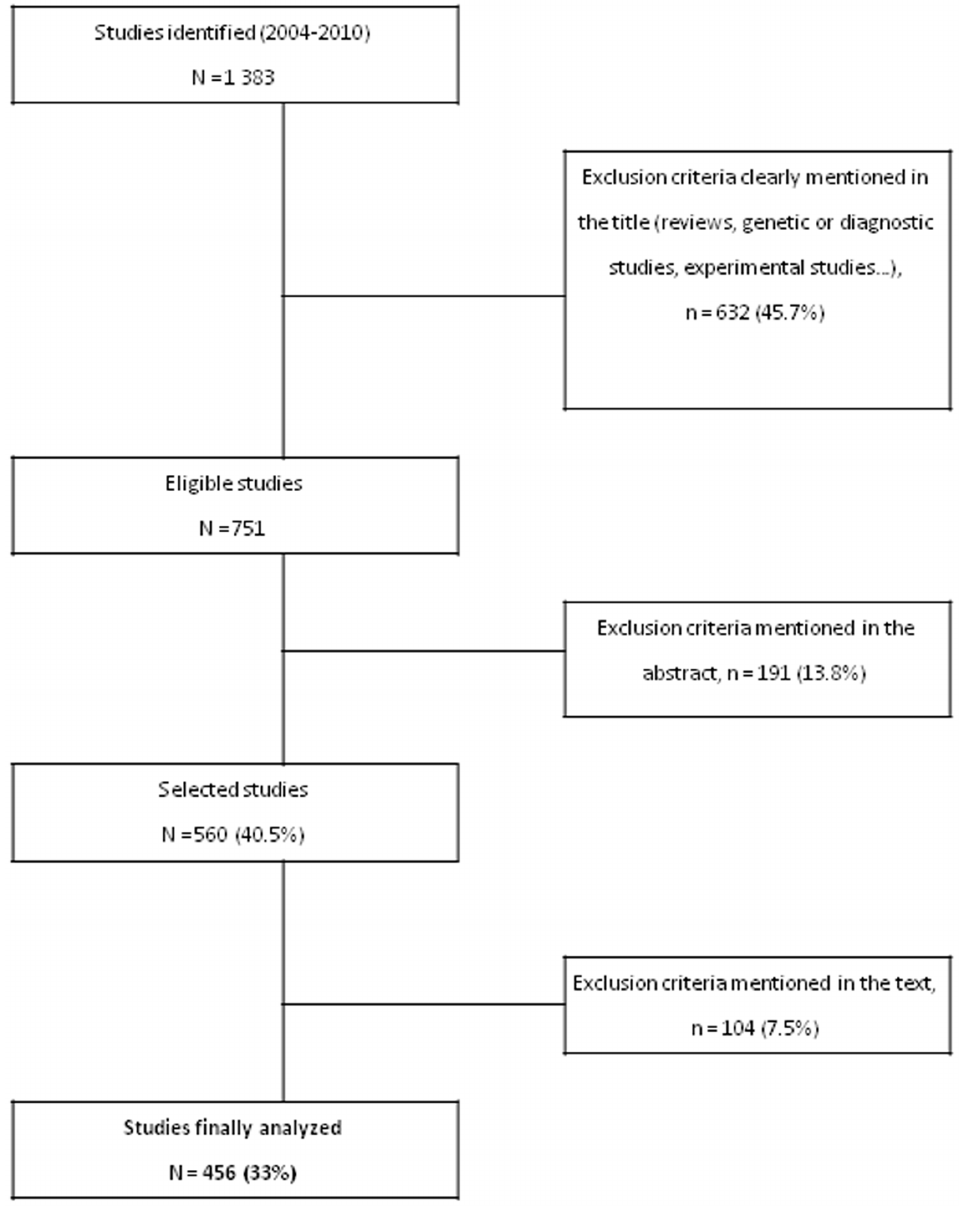
Figure 1. Flow diagram.